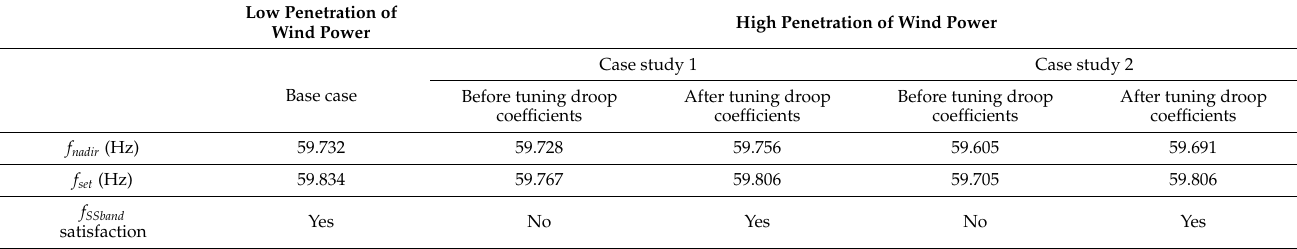
Table 3. Summary of results for all case